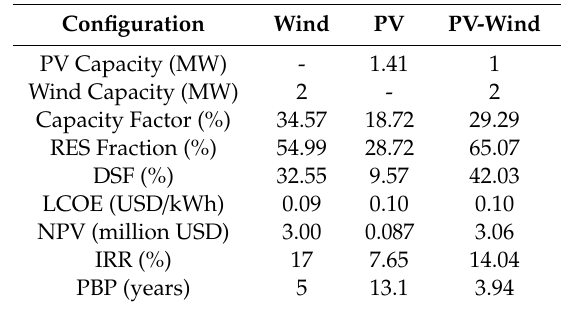
Table2. Themaximumfeasiblewind, PVandPV-windhybridsystemscapacitiesinGwanda, Zimbabwe, in addition to their economic and technical